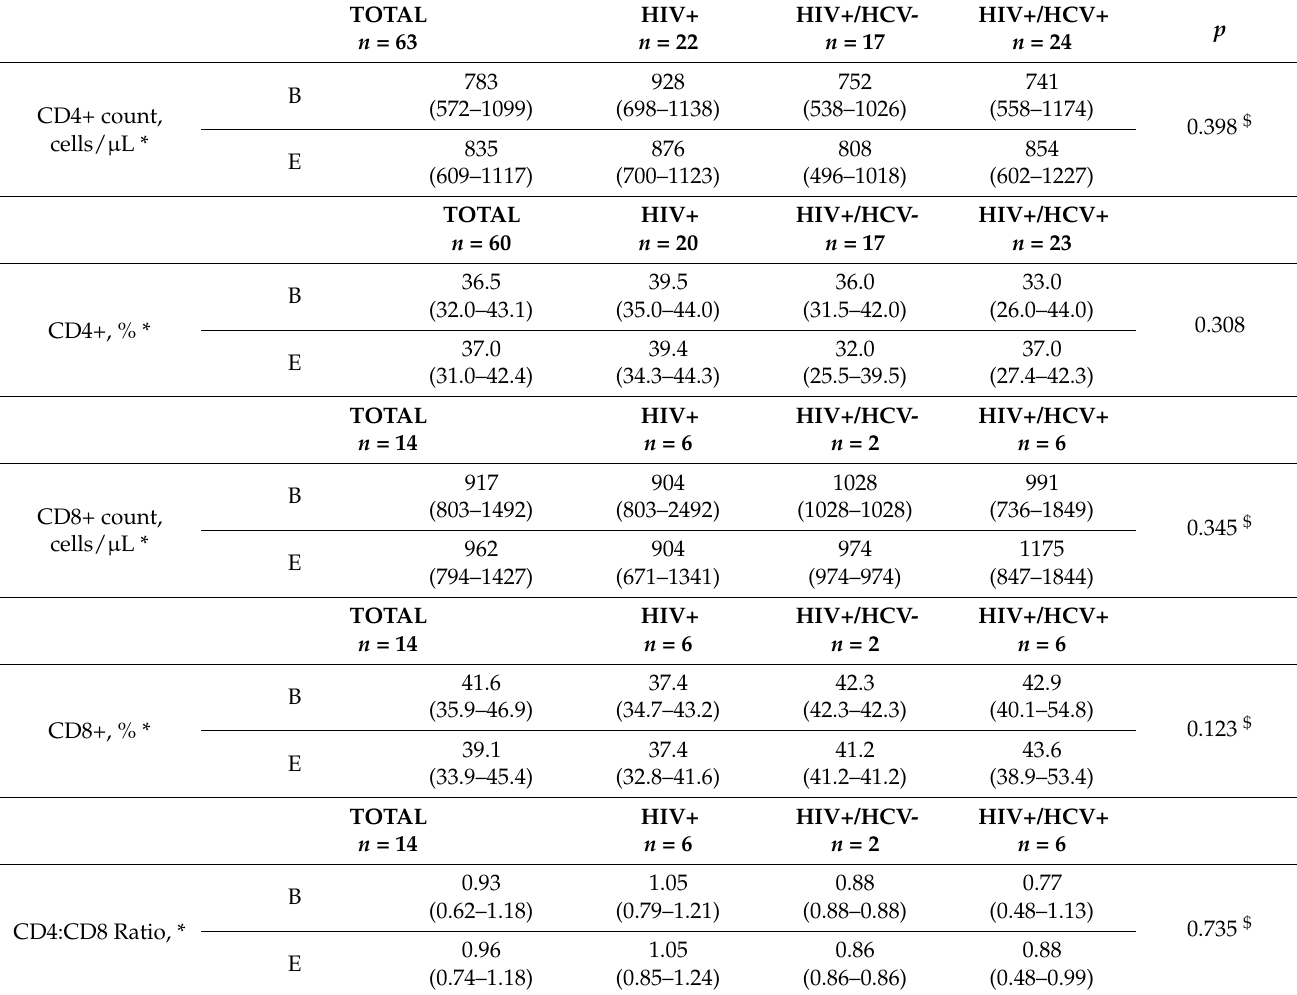
Table 2. Lymphocytic subpopulations of the study